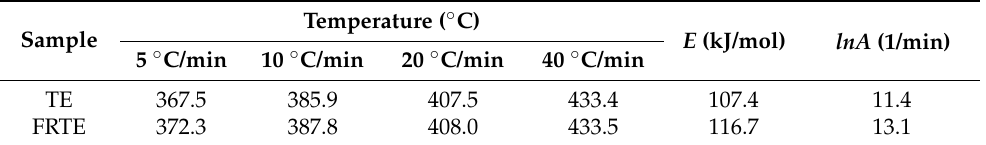
Table 3. Kinetic data using the Kissinger method. Sample